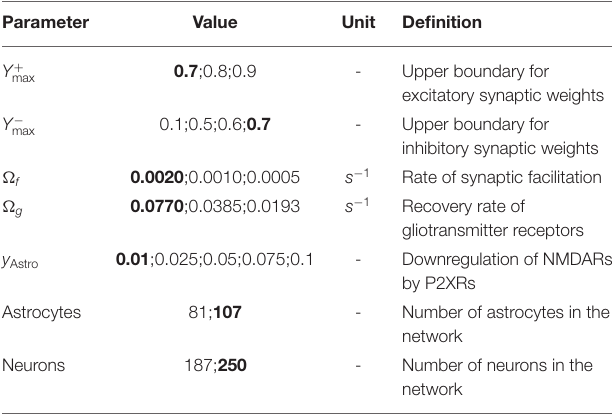
TABLE 1 | Used parameters for simulating healthy and SCZ neuron-astrocyte networks.